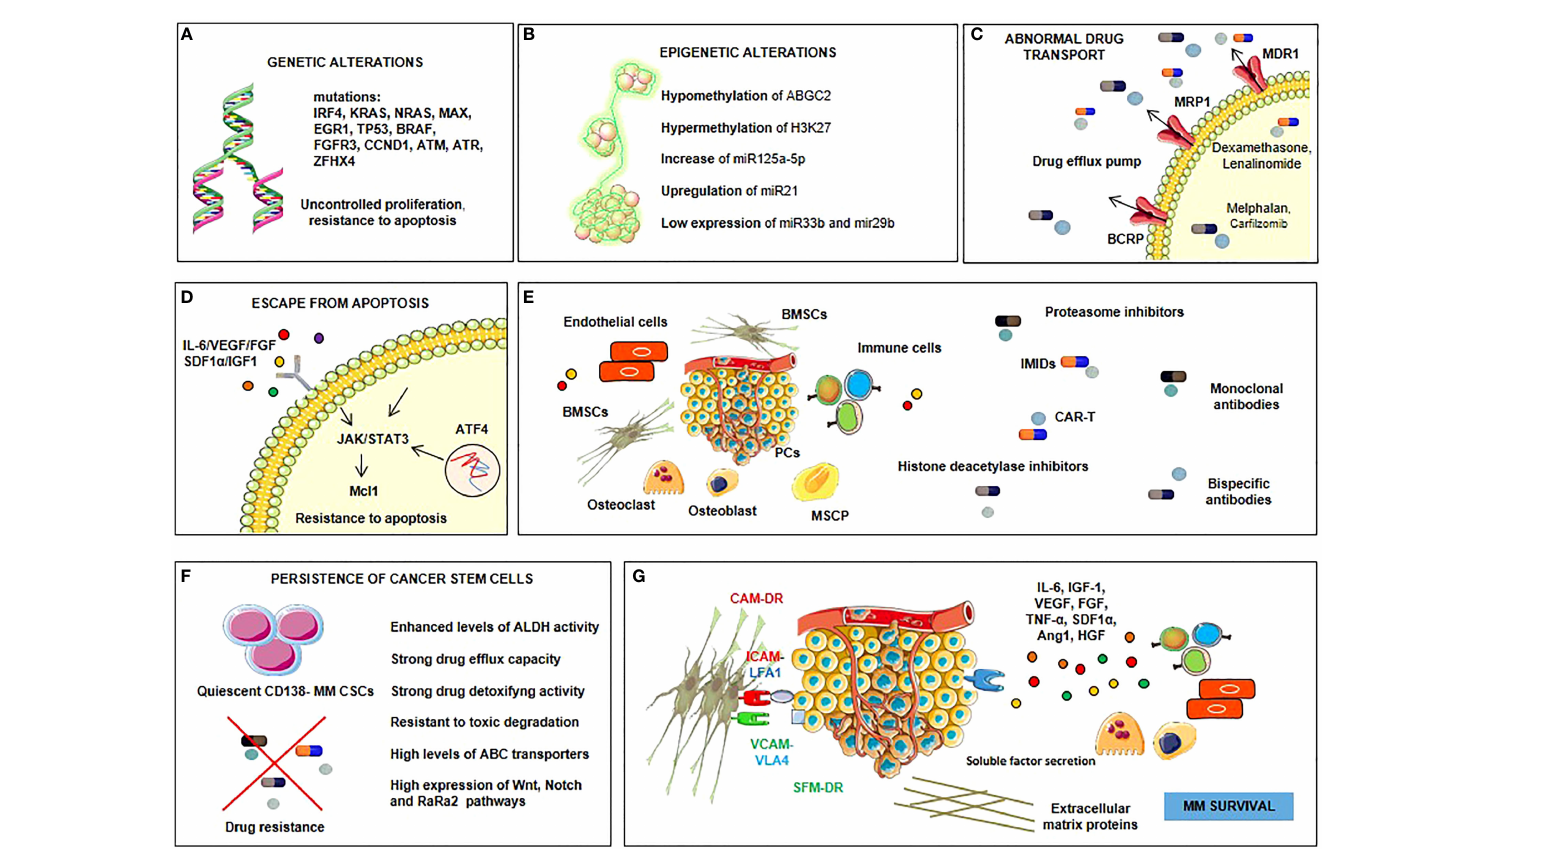
FIGURE 1 Drug resistance in MM involves intrinsic or extrinsic mechanisms. Intrinsic ones are genetic (A) and epigenetic (B) alterations. Genetic alterations (A) include mutations of a lot of genes such as interferon regulatory factor-4 (IRF-4), KRAS, NRAS, myc-associated factor X (MAX), early growth response protein 1 (EGR1), tumor protein p53 (TP53), BRAF, fi broblast growth factor receptor 3 (FGFR3), cyclin D1 (CCND1), ataxia telangiectasia mutated (ATM), ataxia telangiectasia and Rad3-related protein (ATR) and zinc fi nger homeobox 4 (ZFHX4), which procure uncontrolled proliferation and resistance to apoptosis. Epigenetic alterations (B) involve mechanisms of hypomethylation (ATP-binding cassette G2, ABGC2) and hypermethylation (histone 3 lysine 27, H3k27); upregulation of some microRNAs (miRNAs), such as miR125a-5p and miR21, and downregulation of others, such as miR33b and miR29b. Other intrinsic mechanisms are the overexpression of drug ef fl ux pumps and the alteration of drug targets (C) , dysregulation of intracellular signaling pathways, such as those that mediate apoptosis (Janus kinase (JAK)-signal transducer and activator of transcription 3 (STAT3)- myeloid cell leukemia sequence 1 (Mcl1), autophagy (activating transcription factor 4, ATF4), and DNA repair (D) . Extrinsic mechanisms involve myeloma plasma cell interactions with the BM microenvironment (E) , persistence of cancer stem cells (F) , soluble factors-mediated drug resistance (SFM-DR) and cell adhesion-mediated drug resistance (CAM-DR) (G) resulting from the production of soluble factors such as interleukin (IL)-6, insulin-like growth factor-1 (IGF-1), vascular endothelial growth factor (VEGF), fi broblast growth factor (FGF), tumor necrosis factor-alpha (TNF- a ), stromal cell-derived factor 1-alpha (SDF1- a ), angiopoietin 1 (Ang1), hepatocyte growth factor (HGF) by bone marrow stromal cells (BMSCs) and plasma cells (PCs), and from the overexpression of cell cycle inhibitors, anti-apoptotic members of the B-cell lymphoma-2 (Bcl-2) family and ABC drug transporters in myeloma cells upon direct adhesion with